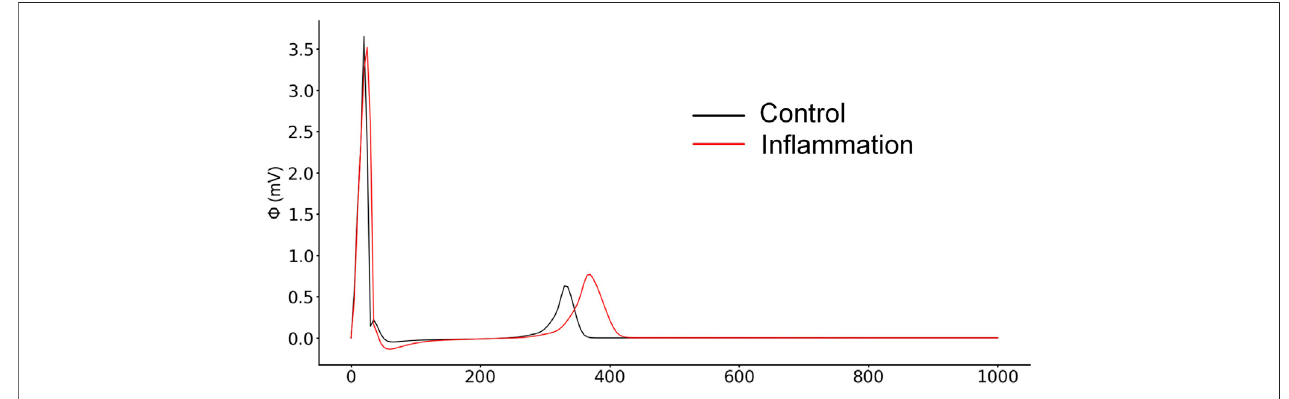
FIGURE 8 | Comparison of pseudo-ECGs between normal and in fl ammatory